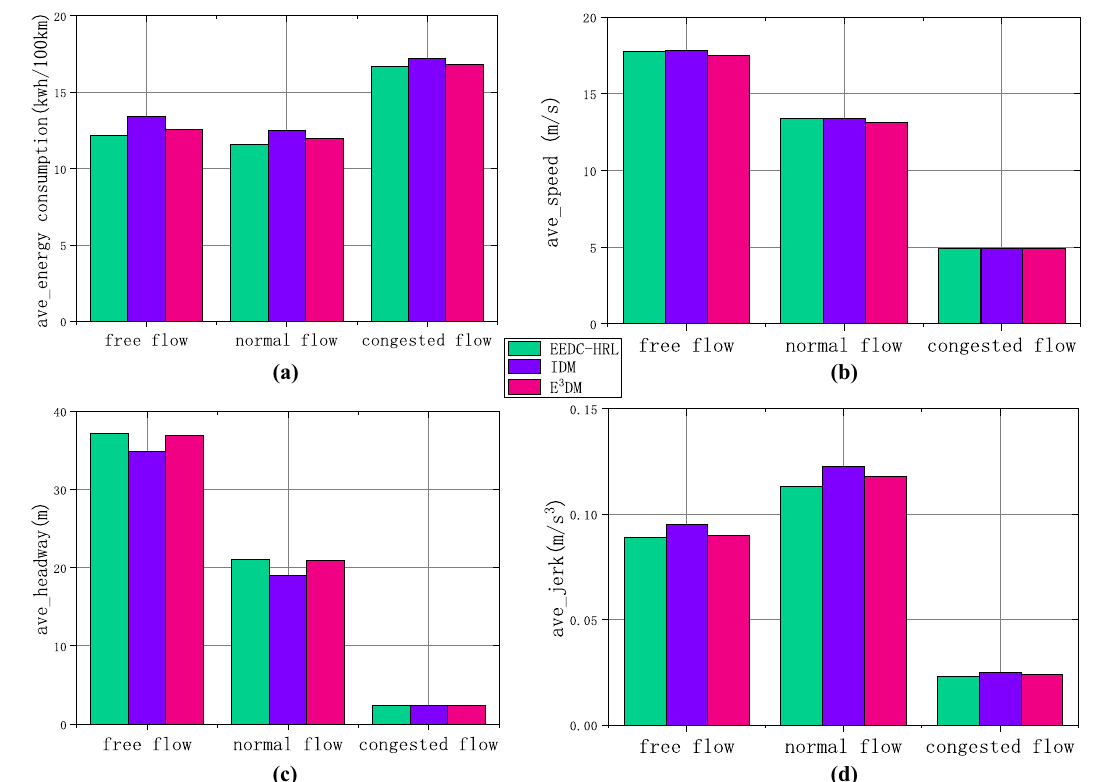
Figure 5 Average values of each metric for EEDC-HRL based on all tested data